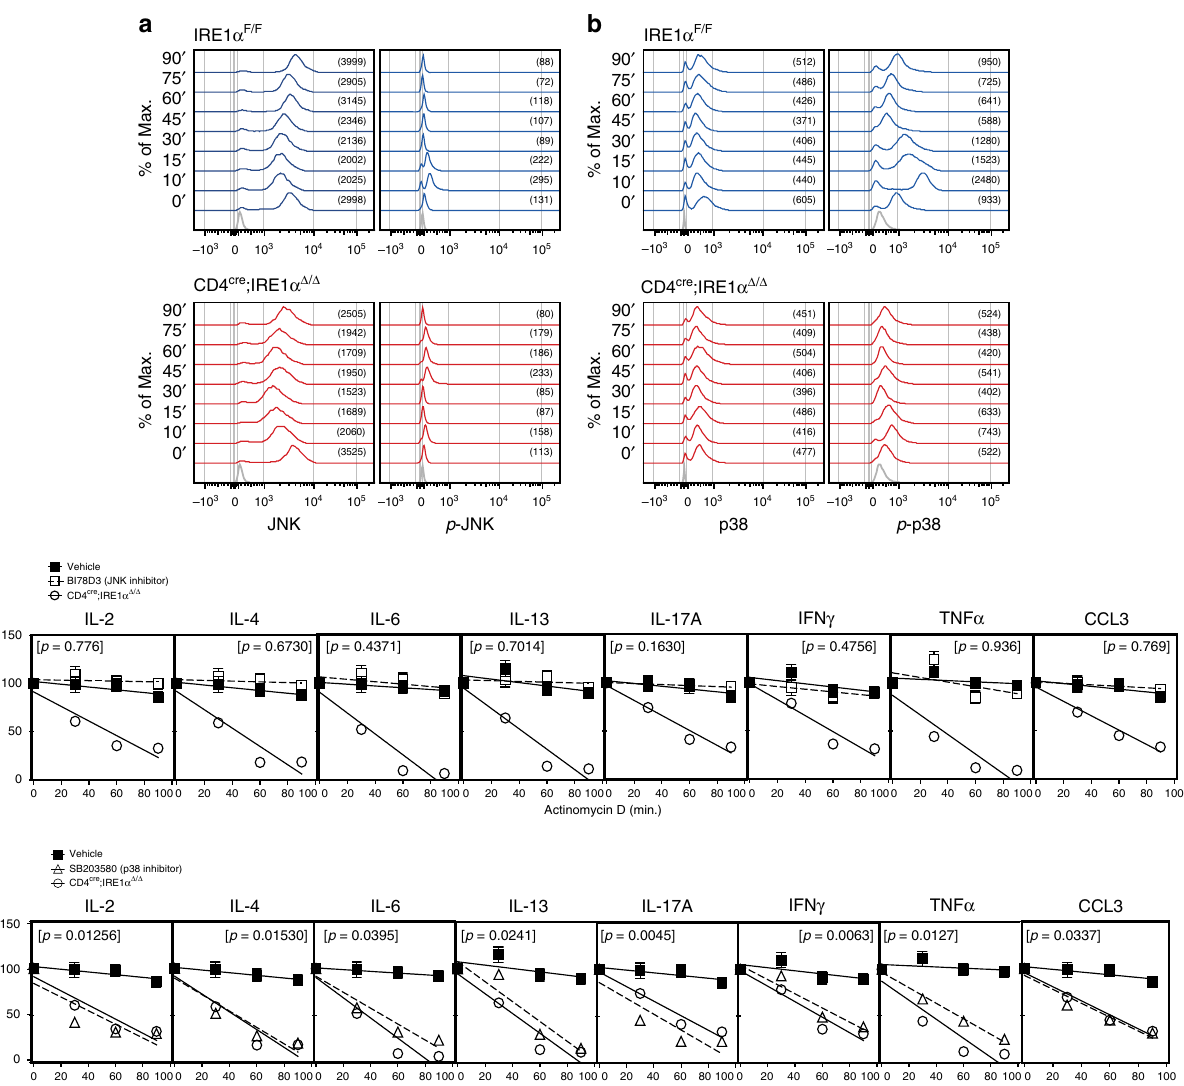
Fig. 5 p38 MAPK regulates cytokine mRNA stability in iNKT cells. a , b Bulk splenic iNKT cells from IRE1 α F/F ( n = 4) and CD4 cre ;IRE1 α Δ / Δ ( n = 4) mice were expanded and restimulated with anti-CD3/CD28 from 0 to 90 min. Histograms represent intracellular expression of JNK, phospho-JNK, p38 and phospho-p38 in control and IRE1 α -de fi cient iNKT cells following TCR restimulation, respectively. Isotype controls (gray) are shown at the bottom of the histogram overlays. Numbers in brackets represent MFI for JNK, p-JNK, p38 and p-p38 expression within FACS-gated iNKT cells. Histograms are representative of three independent experiments. c , d Puri fi ed bulk splenic wild-type iNKT cells were restimulated ex vivo with anti-CD3/CD28 for 3 h in the presence of the JNK inhibitor BI-78D3 ( c ) or the p38 inhibitor SB203580 ( d ), prior to addition of actinomycin D. Resting iNKT cells were then restimulated with anti-CD3/CD28 for 3 h and then treated with actinomycin D. mRNA decay rates were determined by linear regression analysis. Data represents three independent experiments pooled. Error bars show the mean ± s.e.m. p < 0.05 determined by linear regression analysis and